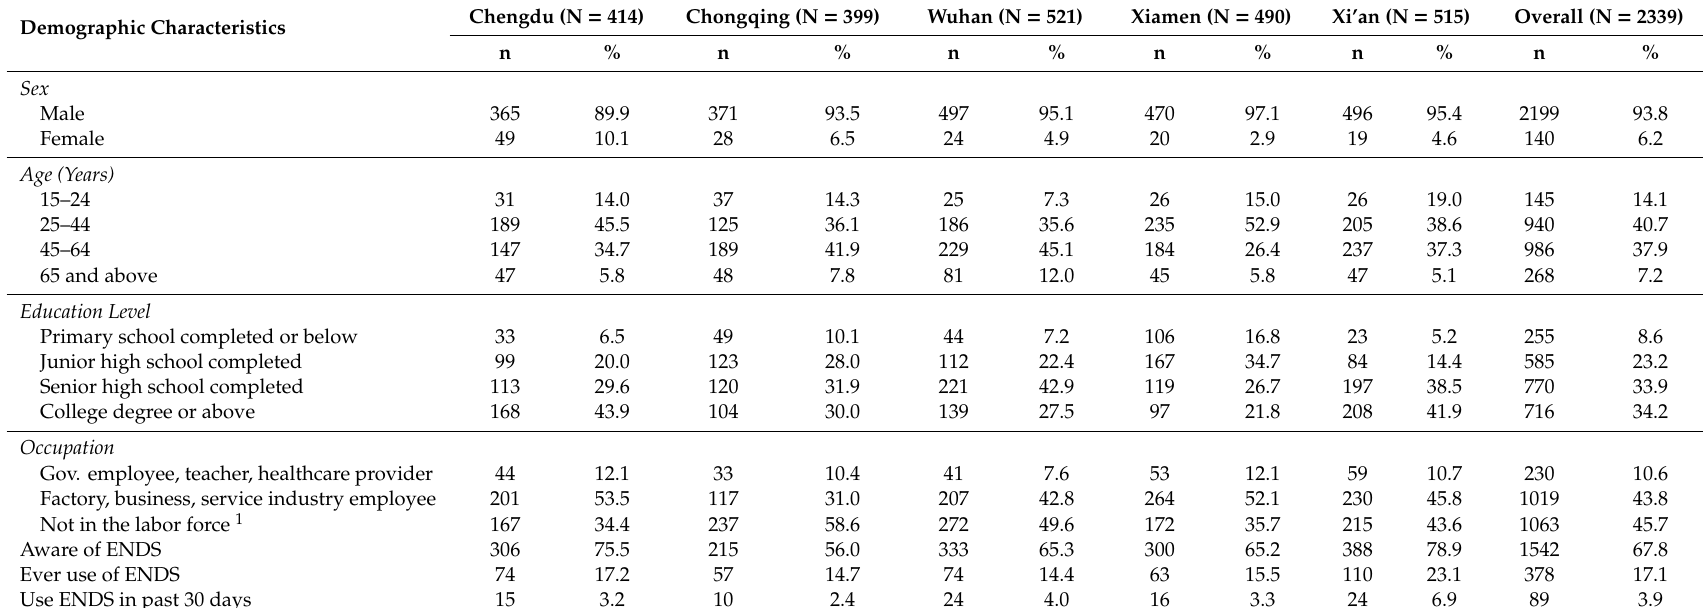
Table A2. Demographic characteristics among adult tobacco smokers–TQS,